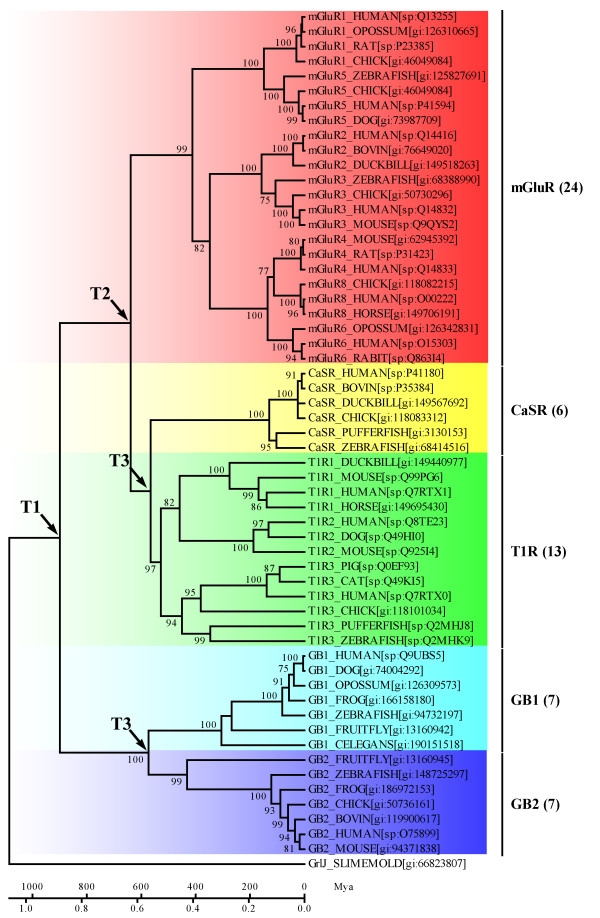
The linearized NJ tree was used to convert evolutionary distances to the relative molecular time scale. A GABAB-like receptor from Dictyostelium discoideum (slime mold), GrlJ, was used as an outgroup to root the tree. Bootstrap values of more than 70% are presented on the node. T1, T2 and T3 indicate time points of the first, second and third gene duplication events respectively. According to the global clock, we estimate T1 = 899 Mya, T2 = 638 Mya and T3 = 565–573 Mya. The split time of Dictyostelium discoideum (1085 Mya) was used to calibrate the timescale.